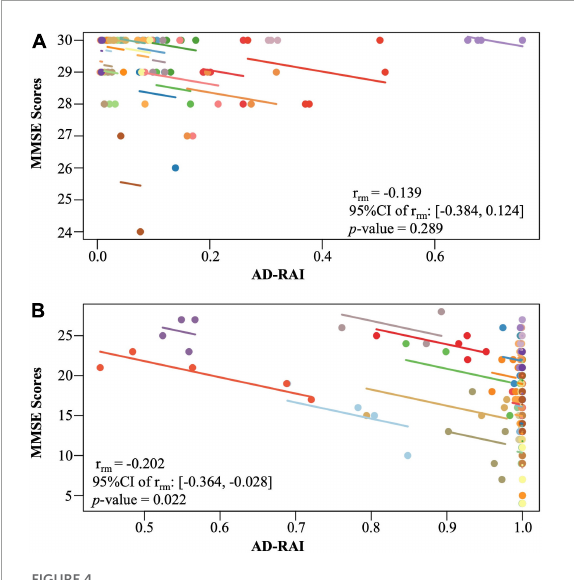
FIGURE4 Intra-participant correlation between AD-RAI and MMSE in controls (A) and in AD patients (B) . The same-coloured dots represent paired measures of AD-RAI and MMSE taken on the same participant over the time. The coloured lines showed the correlation between AD-RAI and MMSE for each participant. AD-RAI, Alzheimer’s disease-resemblance atrophy index; MMSE, Mini-Mental State